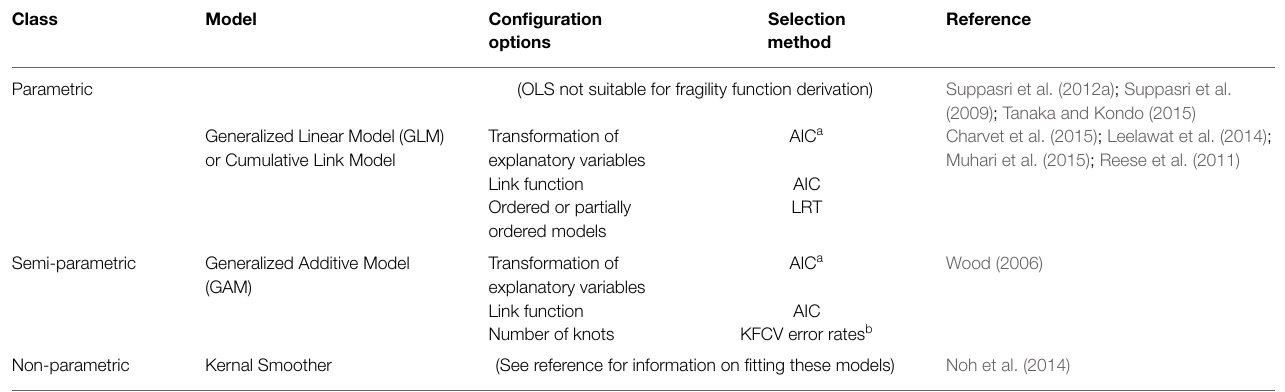
TABLE 10 | Statistical model types and model comparison methodologies [adapted from Macabuag et al.